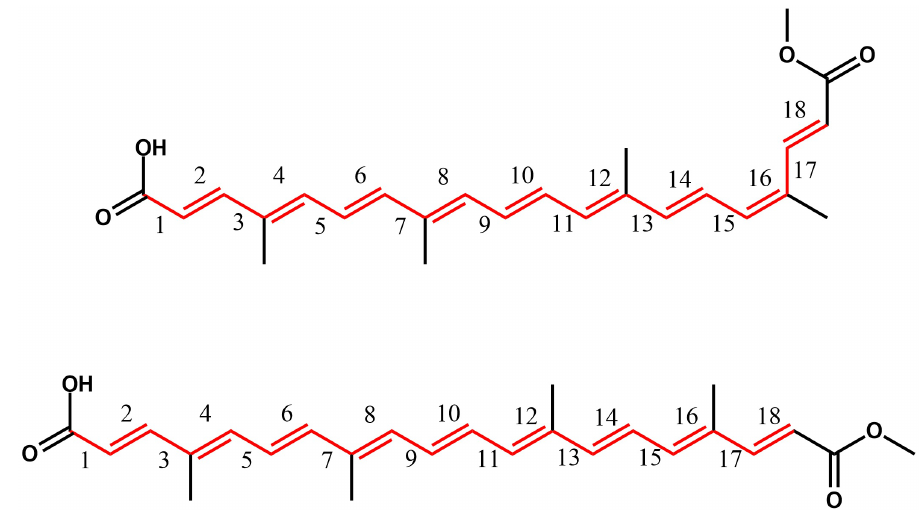
Figure 3. Examined single and double bonds to determine the BLA value.